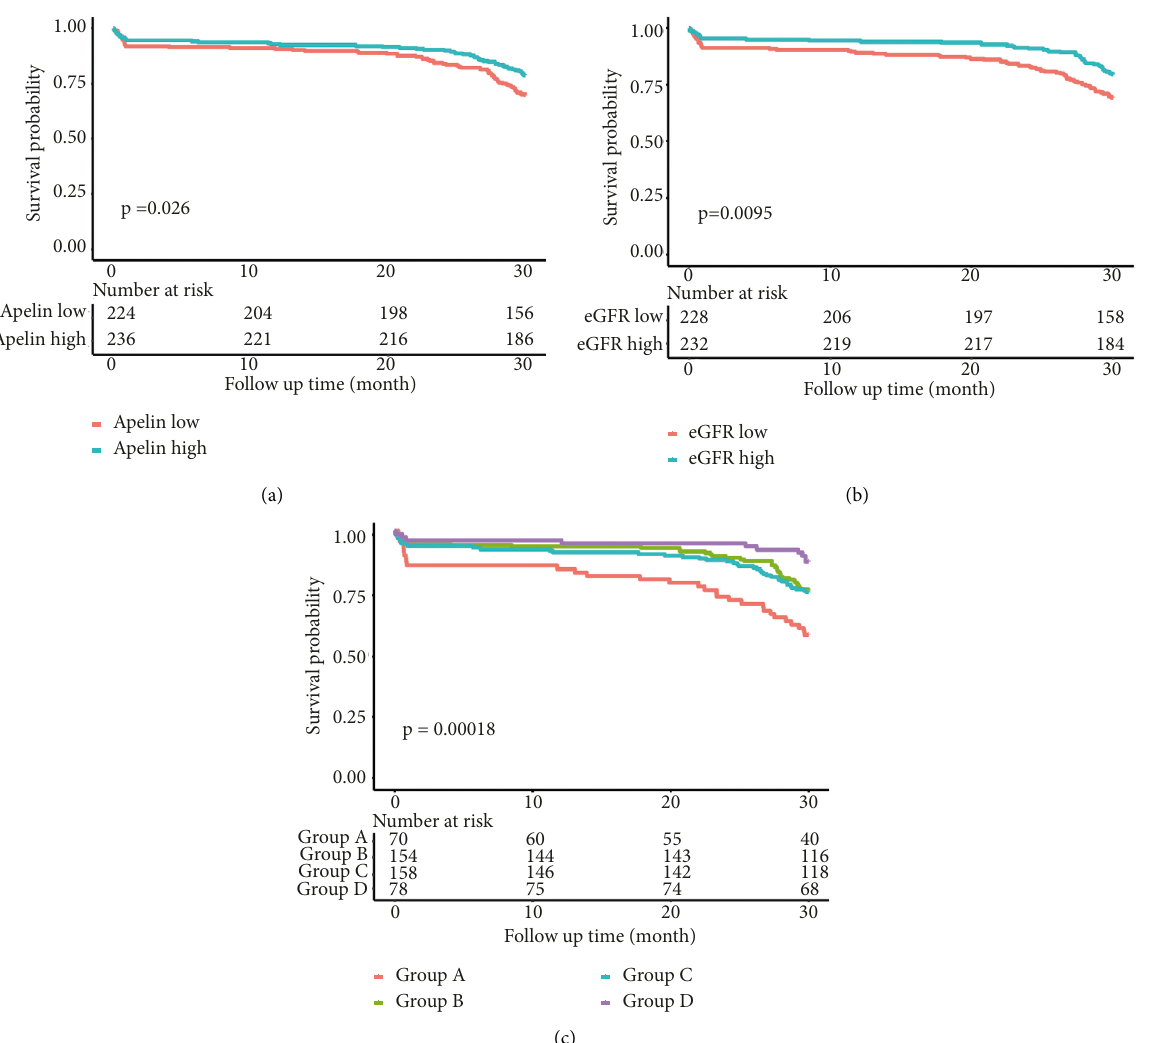
Figure 2: Kaplan–Meier curves for MACE. Kaplan–Meier curves for MACE based on apelin-12 (a), or eGFR (b), or the combination of apelin-12 and eGFR (c). eGFR: estimated glomerular filtration rate; MACE: major adverse cardiac